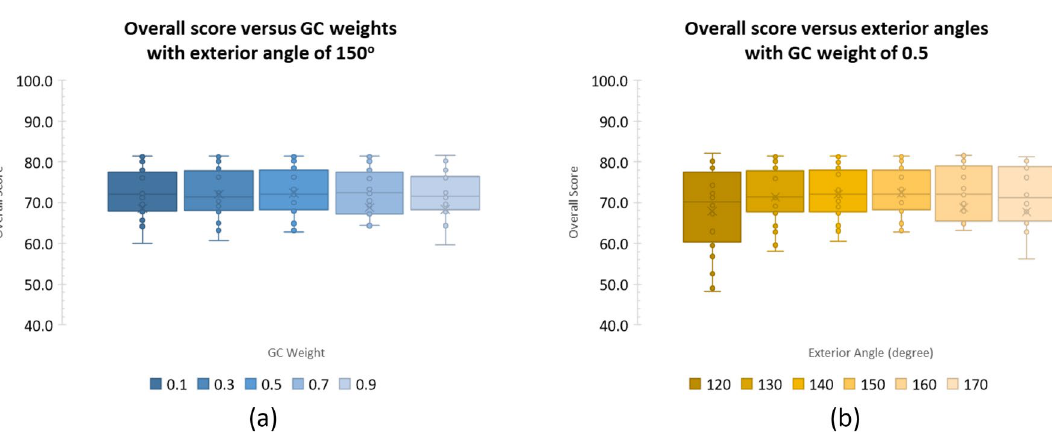
Figure 11. ( a ) Score variability with respect to Graph Cut weights, between 0.1–0.9. ( b ) Score variability with respect to Exterior angle, between 120–170 degrees.